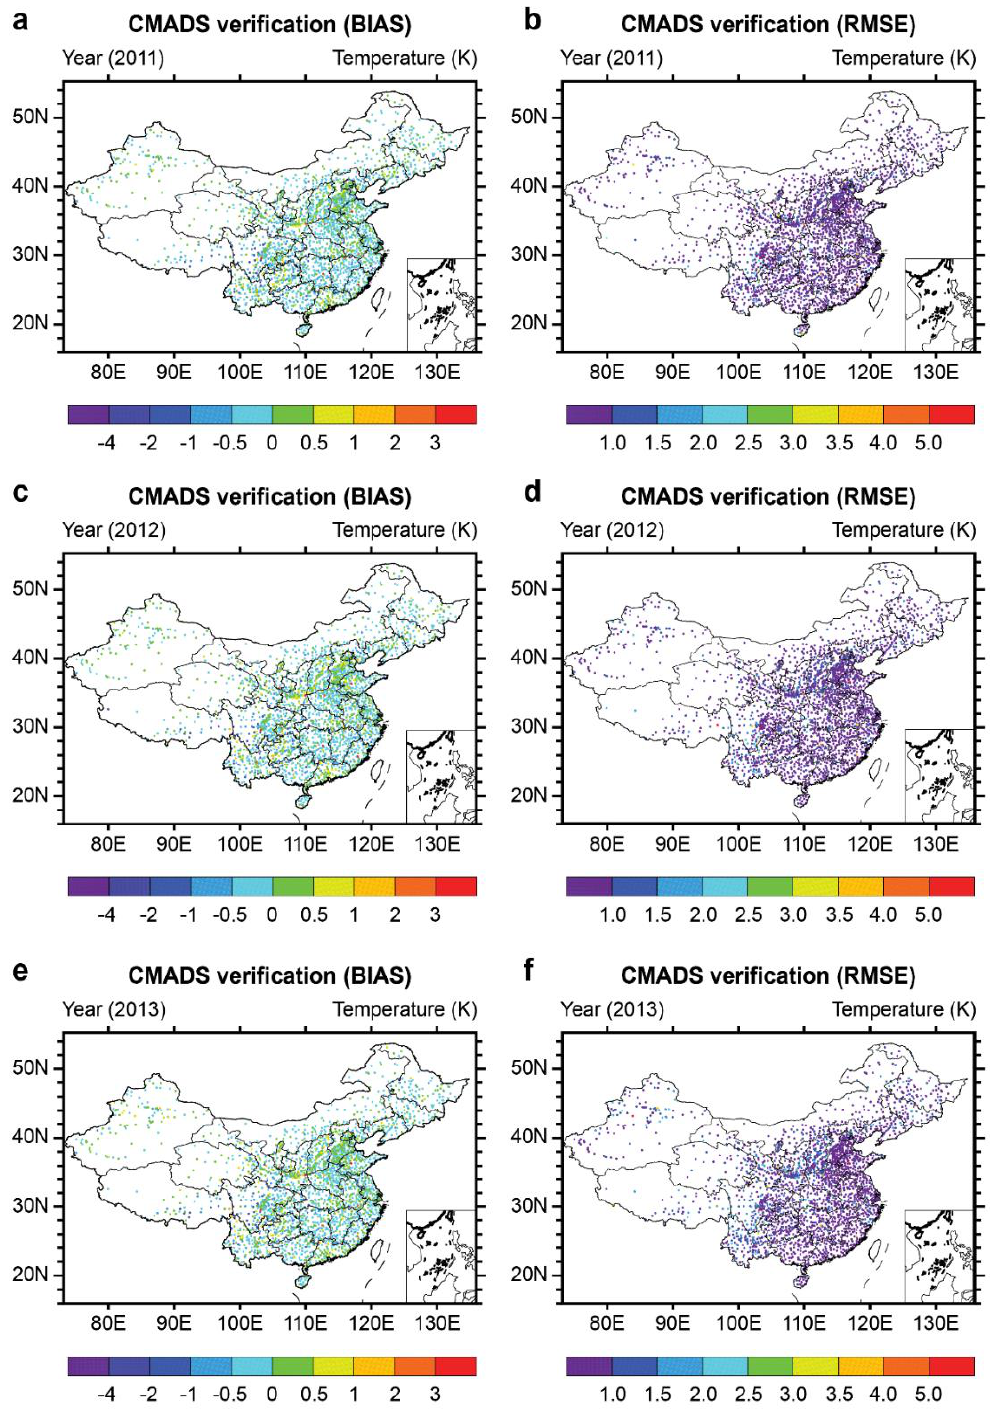
Figure 4. The evaluation of indicators for temperature in China (2011–2013). ( a ) The spatial distributions of the biases for the temperature in year 2011, ( b ) The spatial distributions of the RMSEs for the temperature in year 2011, ( c ) The spatial distributions of the biases for the temperature in year 2012, ( d ) The spatial distributions of the RMSEs for the temperature in year 2012, ( e ) The spatial distributions of the biases for the temperature in year 2013, ( f ) The spatial distributions of the RMSEs for the temperature in year 2013.